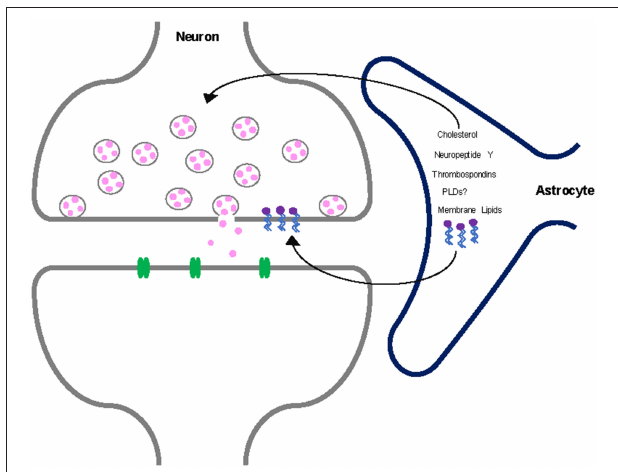
FIGURE 1 | Astrocytes secrete many factors that are critical to neuron function such as cholesterol, neuropeptide Y, thrombospondins, and other metabolic intermediates. We hypothesize that membrane lipids are also secreted by astrocytes and taken up by neurons to regulate neurotransmission. Additionally, PLDs selectively expressed within astrocytes may contribute to this astrocytic lipid